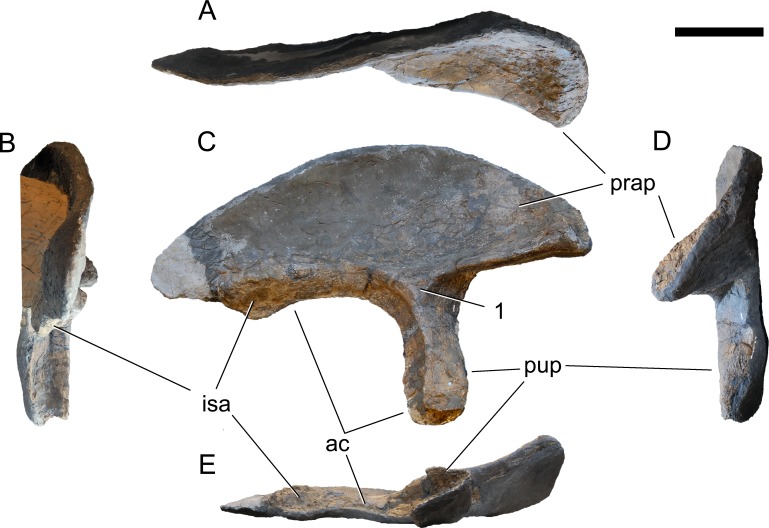
Right ilium of Galeamopus pabsti SMA 0011.The ilium is shown in dorsal (A), posterior (B), lateral (C), anterior (D), and ventral (E) view. Note the triangular depression above the pubic peduncle (1). The yellowish area in B is artificial matrix on which the ilium was mounted for display. Abb.: ac, acetabular surface; isa, ischial articular surface; prap, preacetabular process; pup, pubic peduncle. Scale bar = 20 cm.